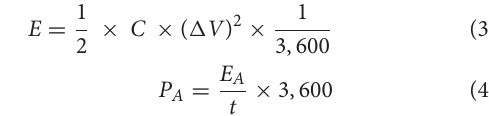
Where C is the areal capacitance of LRPI and is measured in mFcm − 2 , s is the specific area of the electrodes (1 cm 2 in our case), v f and v i are the final and initial voltages (in Volts),